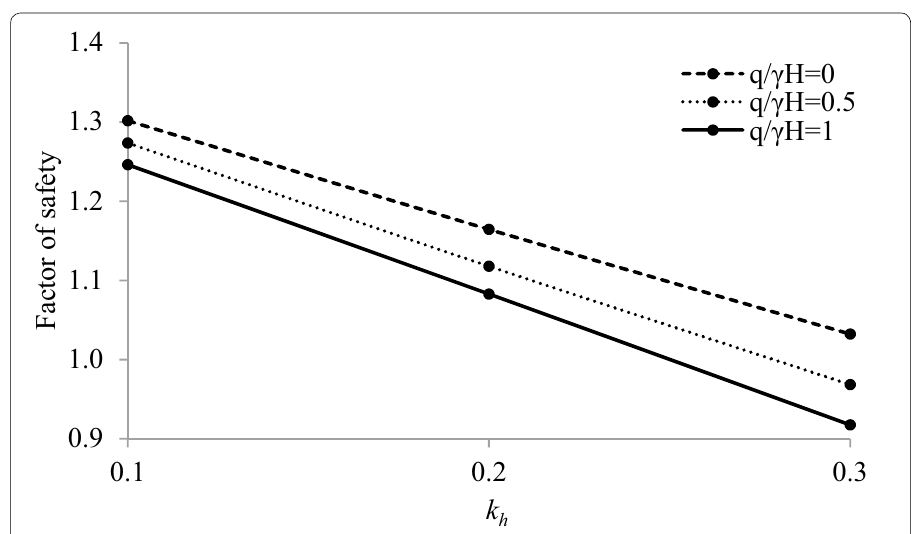
Fig. 9 The variations of factor of safety with different surcharge for φ